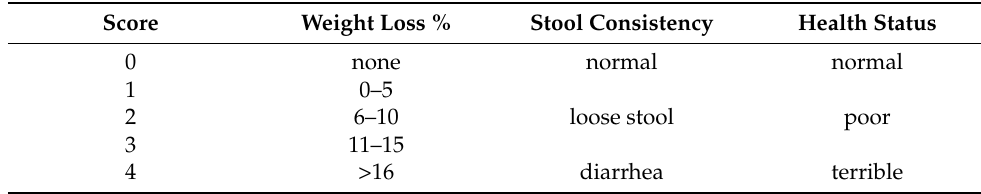
Table 1. The standard DAI